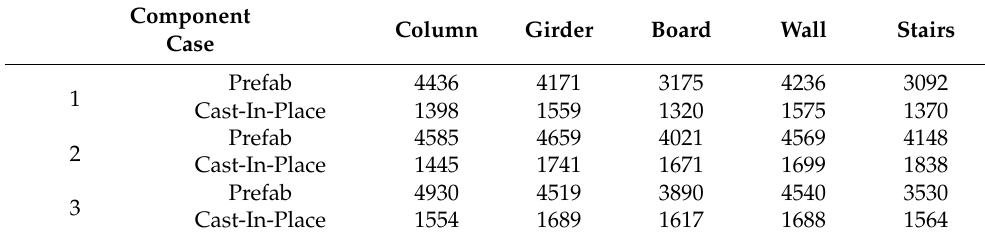
Table 3. Cost of each component (m 3